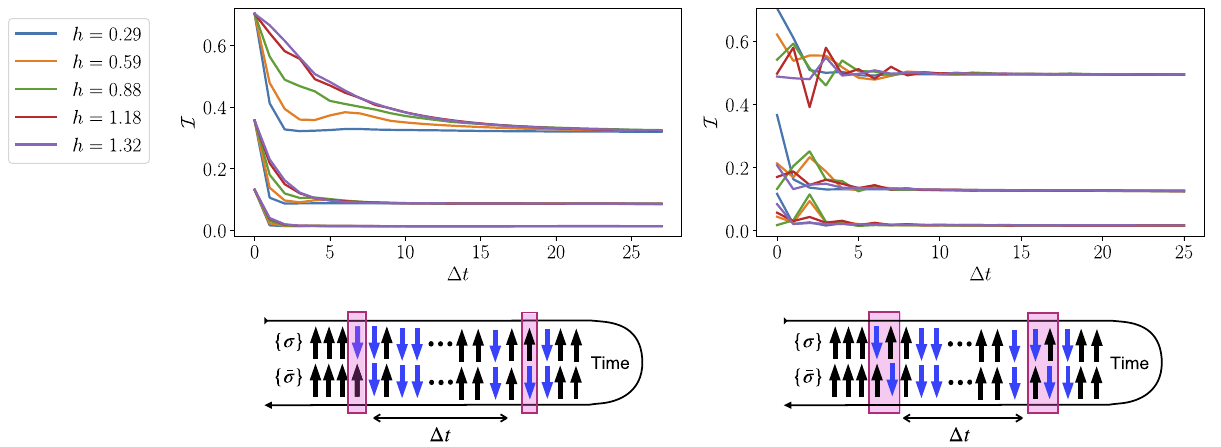
FIG. 10. Influence matrix elements of two blips. Left (right): Blips of length one (two) separated by sojourns of duration Δ t . Detuning from the PD points, δ J ¼ δϵ ¼ 0 . 06 , 0.15, 0.3, increasing from bottom to top. Different values of h are reported in the legend. In both cases, I ð q 1 ; c ; q 2 Þ decays to the product I ð q 1 Þ I ð q 2 Þ of the values of individual blips, with I ð q ↑ Þ ¼ I ð q ↓ Þ ¼ cos ð 2 J Þ